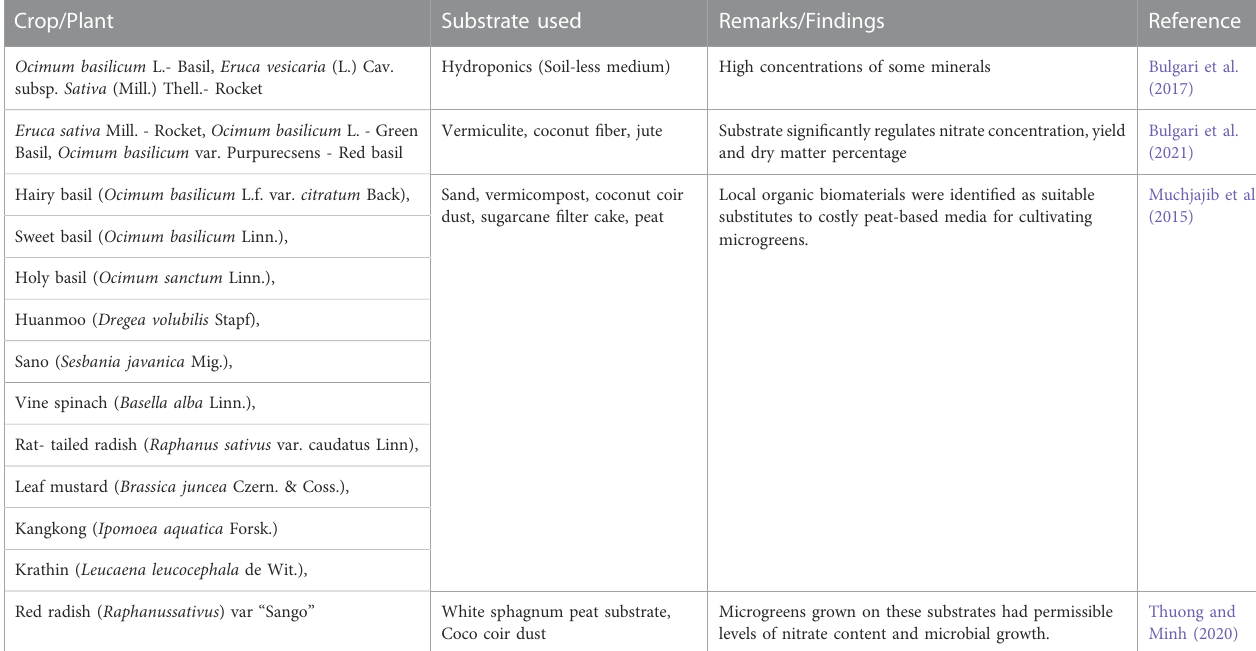
TABLE 3 Different growth media/substrate used in different plants for microgreens cultivation. Crop/Plant Substrate